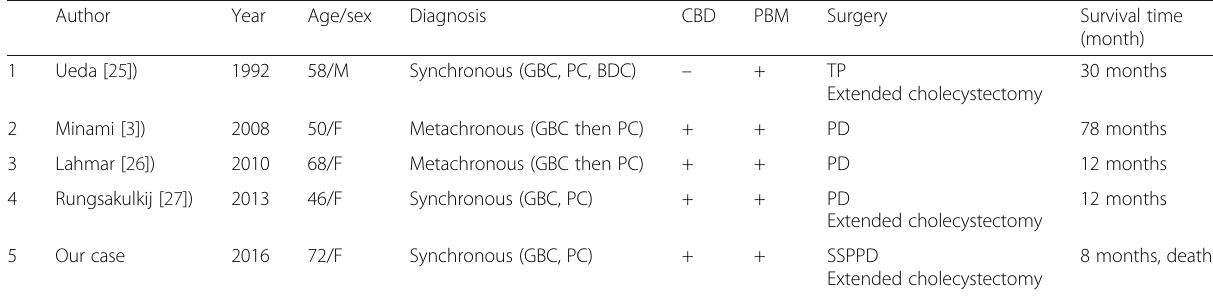
Table 1 Characteristics of reported patients with pancreatobiliary maljunction and double cancer of the pancreas and